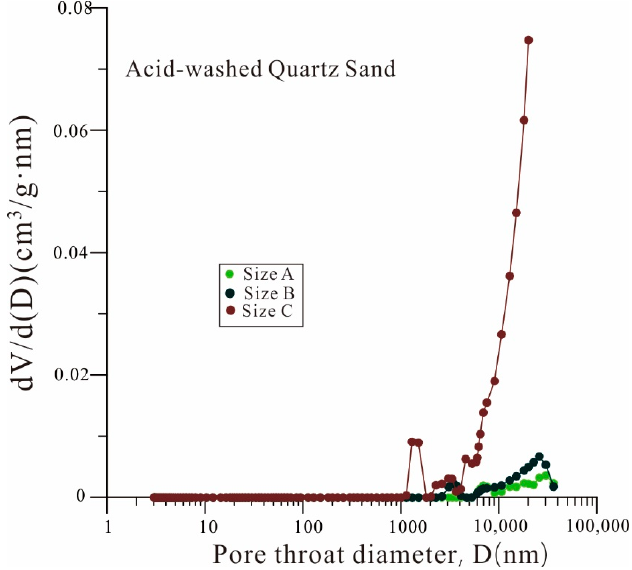
Figure 8. Pore volume distribution vs. pore-throat diameters of quartz samples with three different particle sizes.